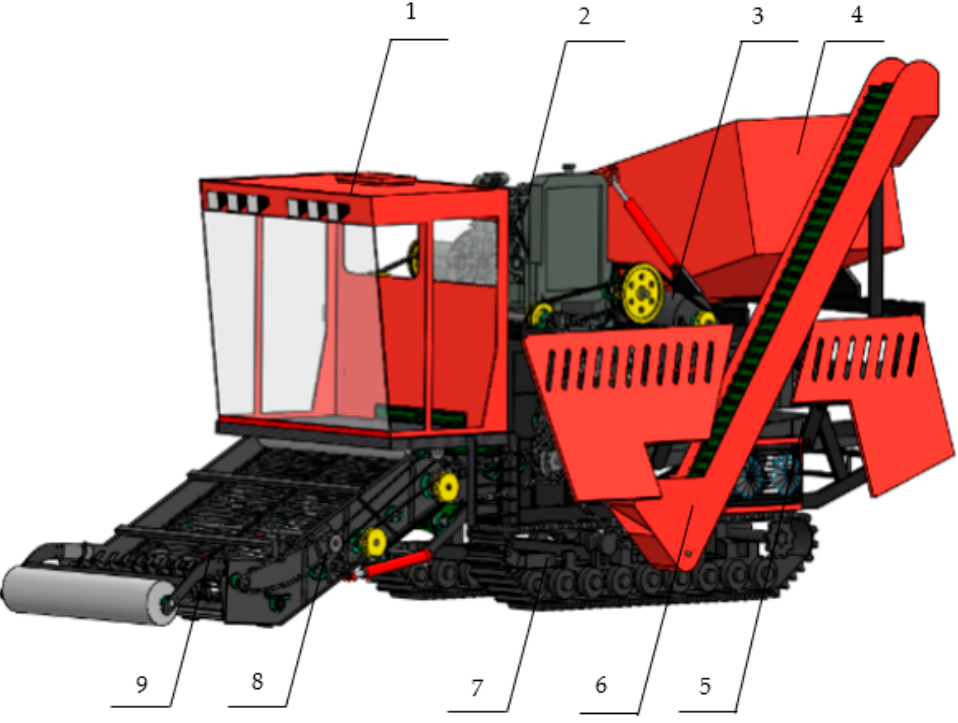
Figure 3. The whole structure of the tiger-nut combine harvester. 1. Driving cab; 2. Engine; 3. Tuber picking and screening device; 4. Collecting box; 5. The hydraulic system; 6. Squeegee lift conveyor; 7. Crawler device; 8. Hoisting device; 9. Digging device. Table 2. Parameters table of the tiger-nut combine harvester.